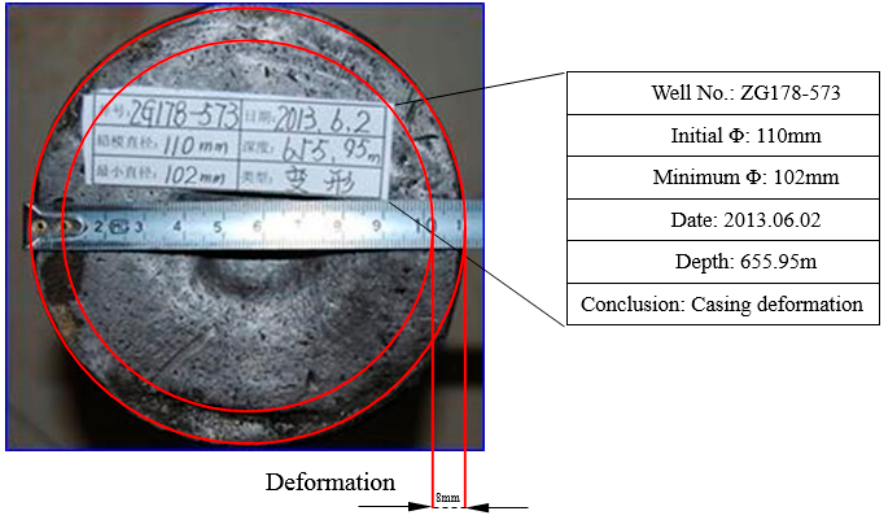
Figure 1. Lead print (collapse deformation at one end of the casing; Jilin oilfield, China).